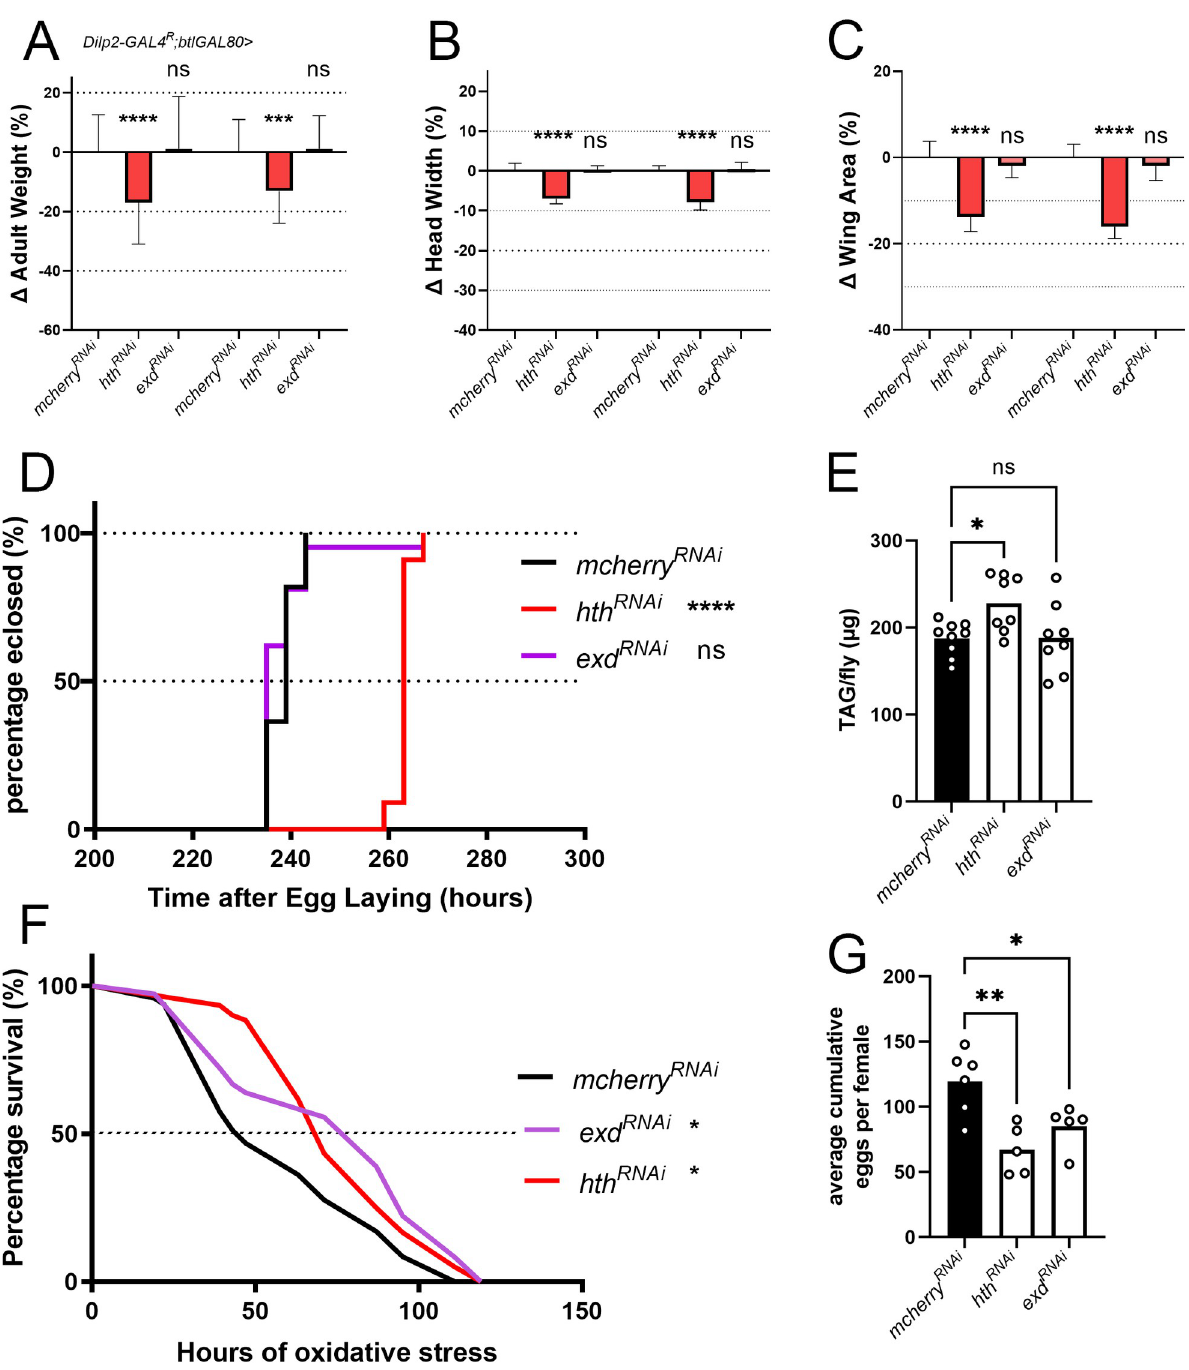
Fig 5. Depletion of Hth and Exd in the IPCs results in phenotypes associated with reduced systemic insulin signalling. (A-C) Knockdown of hth but not of exd results in decreased adult weight, head width and wing area (one-way ANOVA with post-hoc Dunnett’s test comparing to mCherry RNAi controls; ns, not significant, ��� p < 0.001, ���� p < 0.0001). Embryos were collected on yeasted apple-juice plates for 3 hours and allowed to develop to early L1 larvae when they were transferred to food vials at a fixed density (20 larvae per vial). Flies were anaesthetized with chloroform 4–5 days after eclosion for measurements. (D) Knockdown of hth in the IPCs but not of exd results in a developmental delay (one-way ANOVA with post-hoc Dunnett’s test comparing to mCherry RNAi controls; ns, not significant ���� p < 0.0001). (E) Total TAG of female flies is increased upon Hth knockdown but not in case of Exd knockdown (one-way ANOVA with post-hoc Dunnett’s test comparing to mCherry RNAi controls; ns, not significant � p < 0.05). (F) Oxidative stress resistance is increased in flies expressing hth RNAi and exd RNAi . Flies were reared on normal food and aged to 3 days old and placed at controlled densities on food containing 20mM paraquat. Dead flies were scored regularly ( �